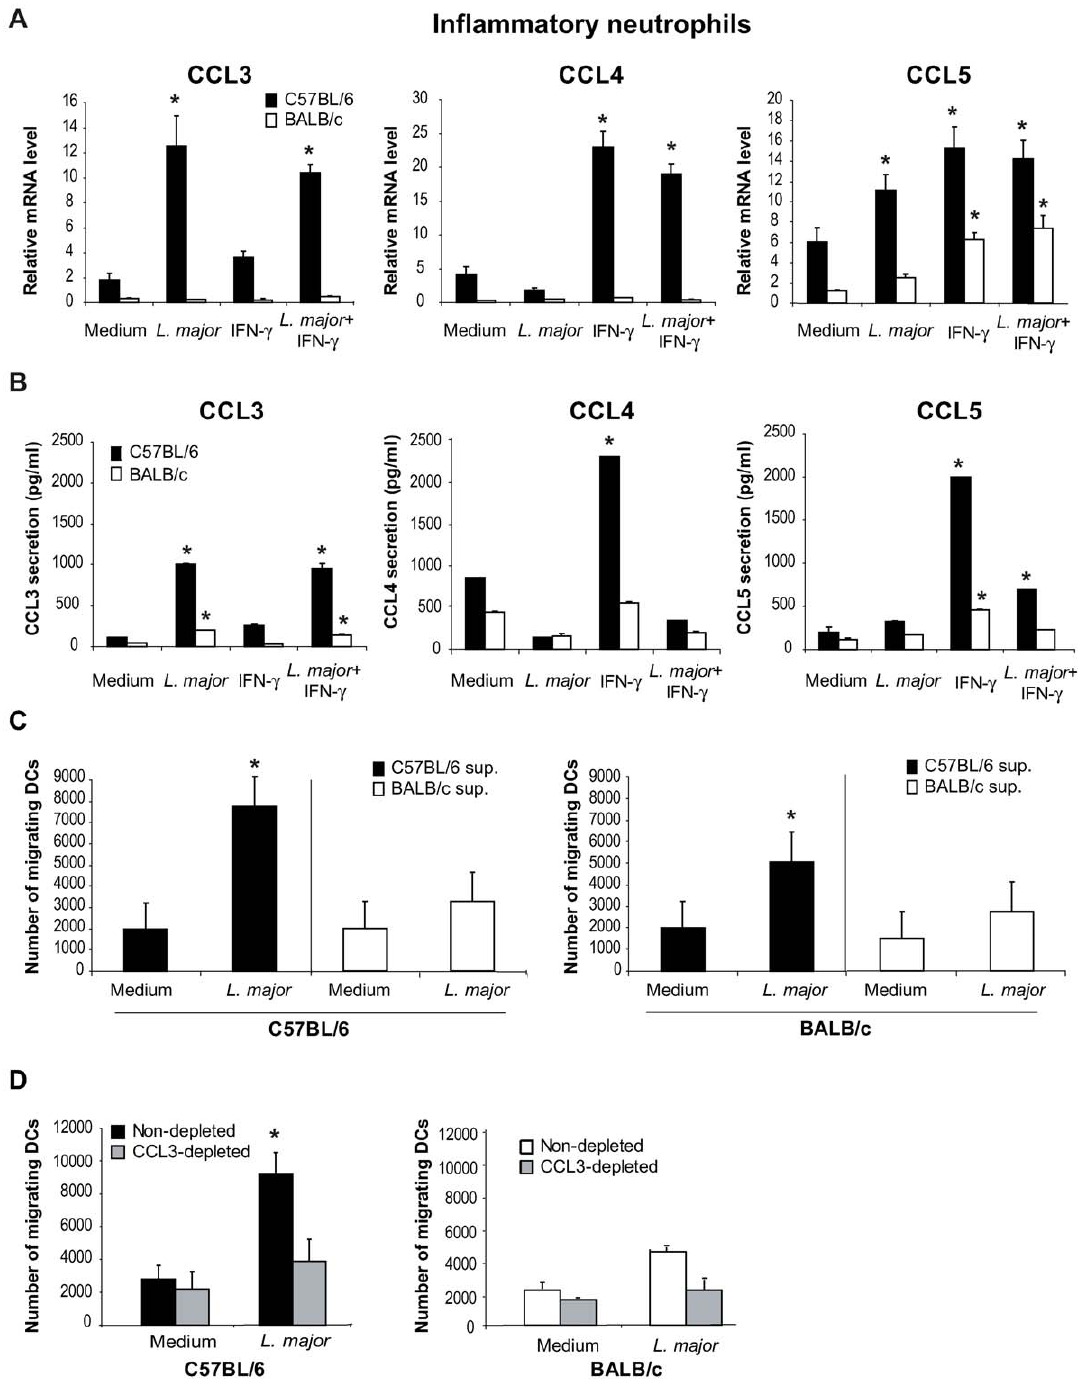
Figure 1. In presence of L.major , neutrophils produce CCL3 which chemo-attracts bone marrow-derived DCs invitro . L. major –i.p. recruited C57BL/6 and BALB/c neutrophils were purified by MACS and incubated with medium, L. major (5:1 parasite:neutrophil ratio), IFN c , or both. (A) Sixteen hours later, neutrophil CCL3, CCL4 and CCL5 mRNA levels were assessed by real-time quantitative RT-PCR, and (B) 24 hours after initiation of culture, chemokine content was measured in cell-free culture supernatants by ELISA. Data are the mean triplicate measurement 6 SEM of neutrophil mRNA or chemokine content in the supernatants. *: p , 0.05 compared to neutrophils cultured with medium only. (C) Supernatants from inflammatory neutrophils cultured in presence or in absence of L. major were tested for their chemotactic activity towards bone marrow-derived DCs in a transwell cell migration assay. The number of DCs that migrated toward neutrophil supernatant is represented. (D) DC migration was similarly assessed in response to neutrophil supernatants depleted of CCL3. *: p , 0.05 as compared to values measured in response to supernatant of neutrophil incubated with medium alone. Data are expressed as mean number 6 SEM of DC that migrated towards neutrophil supernatant (n=3 per group). The results of a representative experiment out of three are shown.